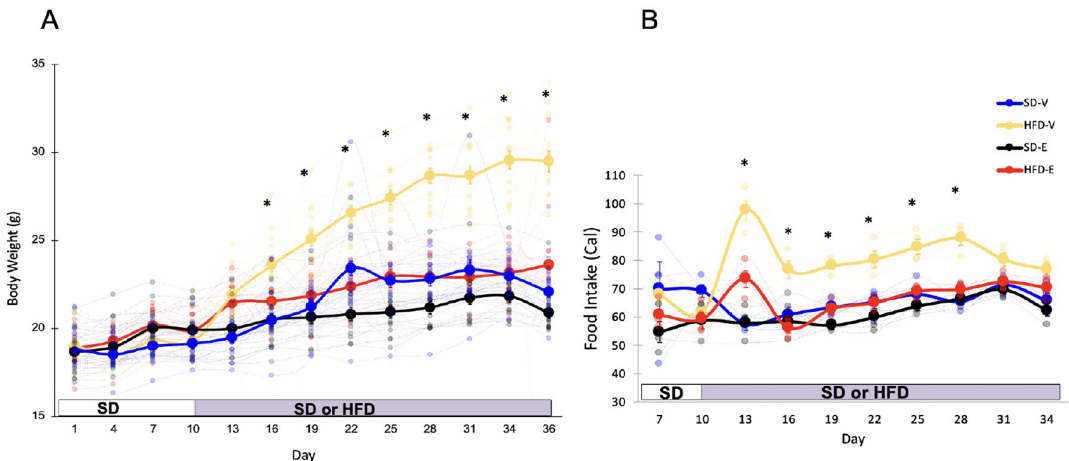
Figure 1. Estradiol prevents HFD-induced obesity and reduces HFD intake in female mice. ( A ) E prevented average body weight gain in mice on a HFD (n = 16/group). ( B ) E decreased caloric intake per cage in mice on a HFD (n = 4 cages/group). Larger circles show mean (± SEM) and smaller circles show individual data points. *Indicate days when HFD-V mice differ from all other groups. P < 0.05, Tukey’s